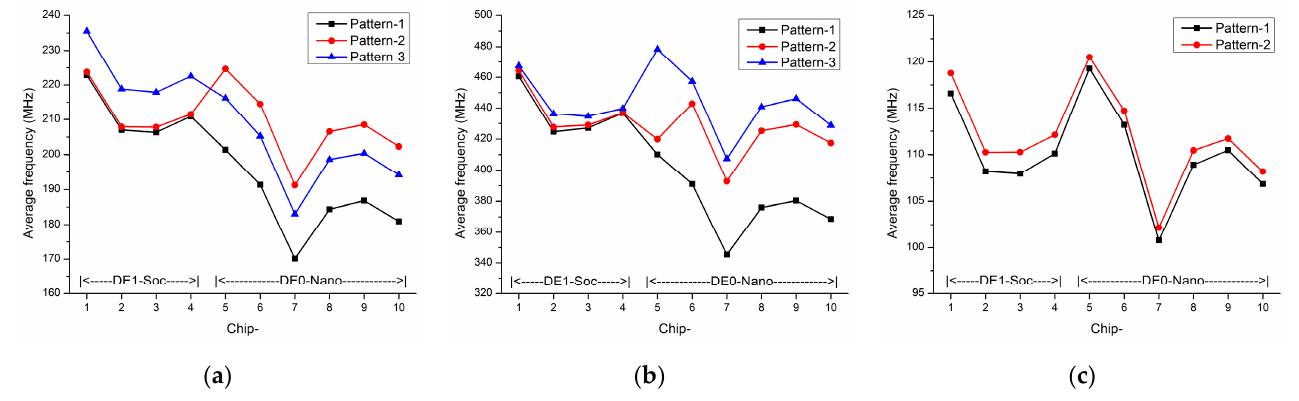
Figure 10. Average frequencies in all chips: ( a ) RO5, ( b ) RO11, ( c ) RO20.